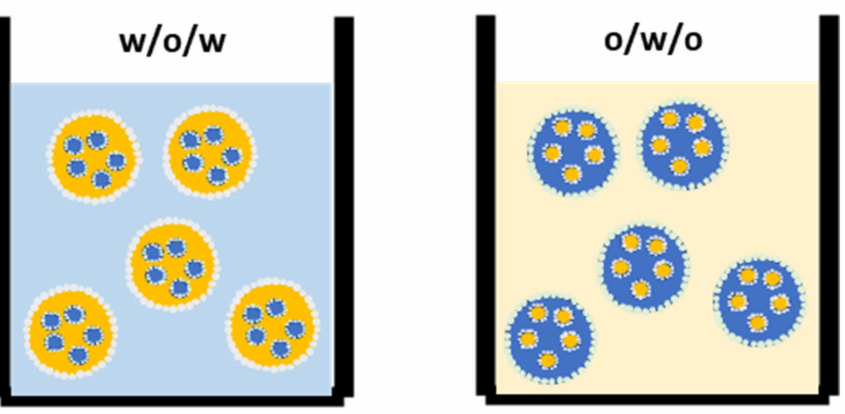
Figure 2. w/o/w and o/w/o PMEs with both interfaces stabilized by PPs (for simple and multiple